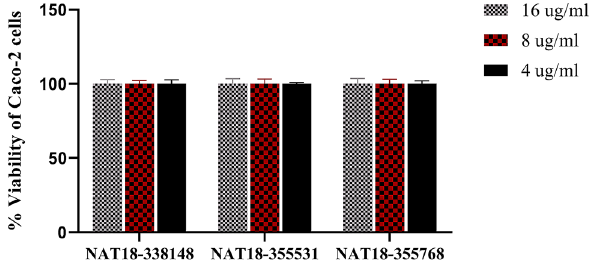
Figure 2. Cytotoxicity assay of hit scaffolds against human colorectal adenocarcinoma (Caco-2) cell line. Percent viable Caco-2 cells measured as ratio of average absorbance relative to DMSO for analyzing cytotoxicity of the hit natural product-derived small molecules at 16 µ g/ml using the MTS 3-(4,5-dimethylthiazol-2-yl)-5- (3-carboxymethoxyphenyl)-2-(4-sulfophenyl)-2 H -tetrazolium) assay. DMSO was used as a negative control to determine a baseline measurement for the cytotoxic impact of each compound. The absorbance values represent an average of a minimum of three samples analyzed for each compound. Error bars represent standard deviation values for the